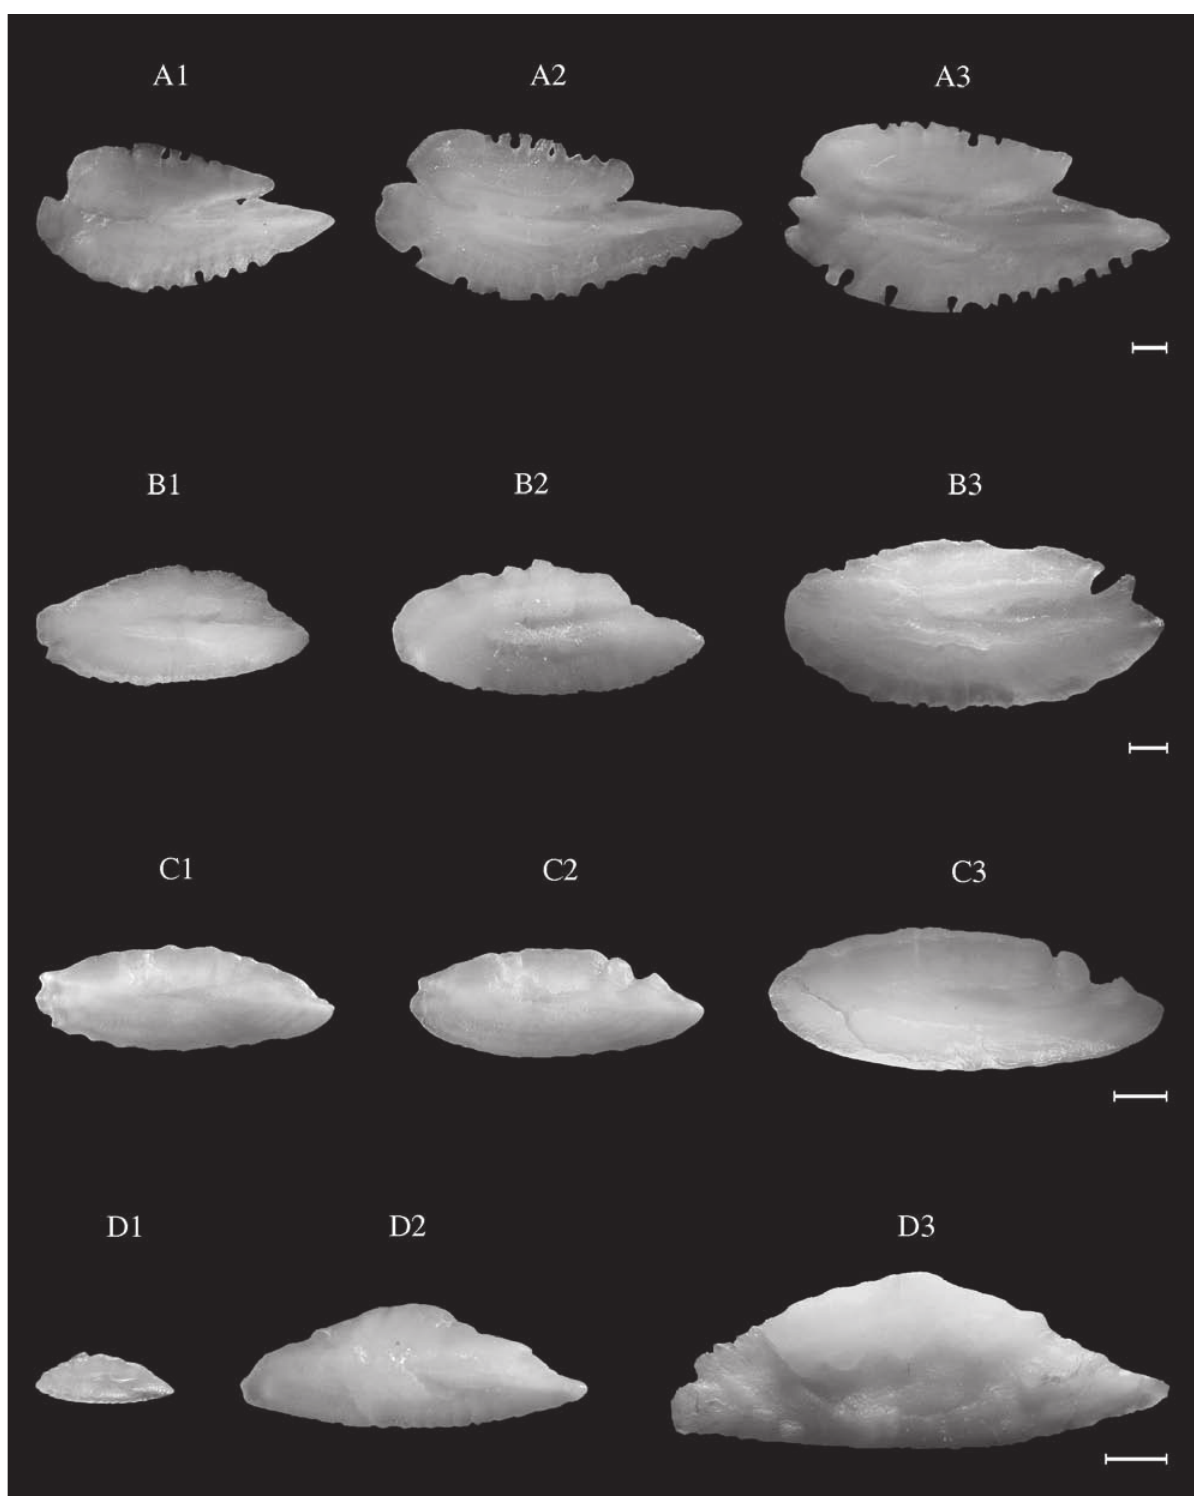
Fig. 83. – Promethichthys prometheus (CEA). TL: A1, 47.0 cm; A2, 58.3 cm; A3, 59.8 cm. Aphanopus carbo . TL: B1, 86.9 cm (CEA); B2, 103.3 cm (NEA); B3, 112.5 cm (CEA). Benthodesmus simonyi . TL: C1, 67.9 cm (NEA); C2, 83.0 cm (NEA); C3, 103.9 cm (CEA). Lepidopus caudatus . TL: D1, 19.0 cm (WM); D2, 76.4 cm (NEA); D3, 152.9 cm (CEA). Scale bar = 1